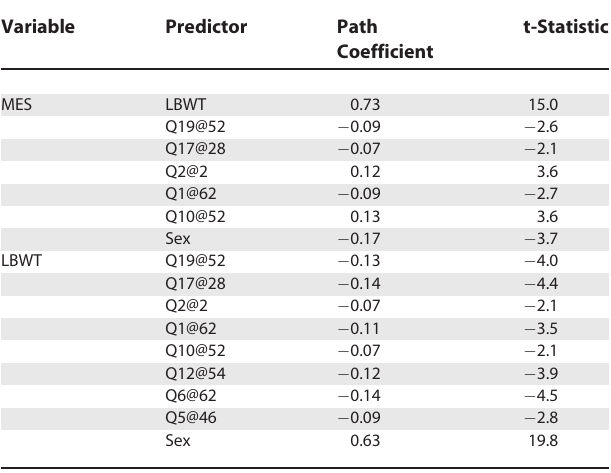
Table 1. Structural Equations of the Mesenteric Fat Pad Model Variable